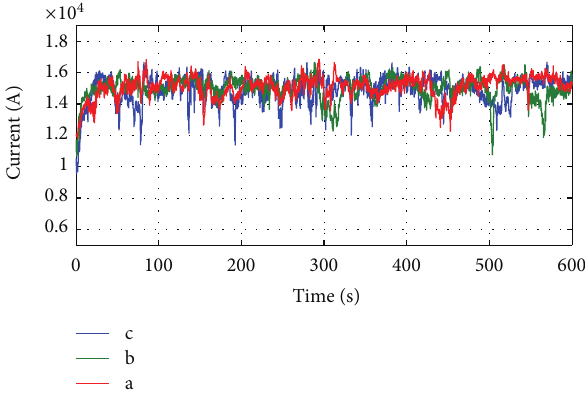
Figure 18: Current curve of intelligent control